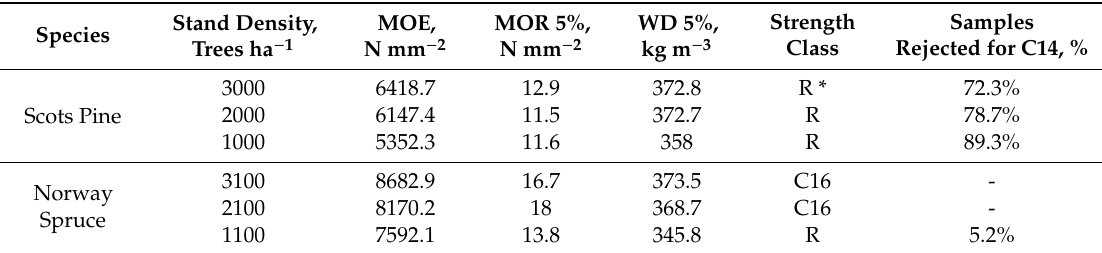
Table 3. Theoretical strength classes of Scots pine and Norway spruce wood samples at the sites with di ff erent stand densities (EN 338:2009).